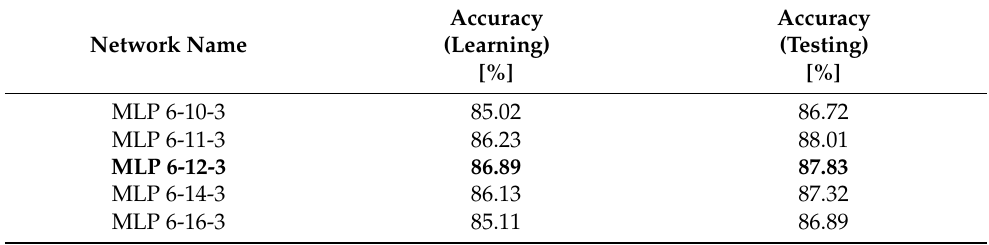
Table 2. Selected ANNs accuracy assessment.